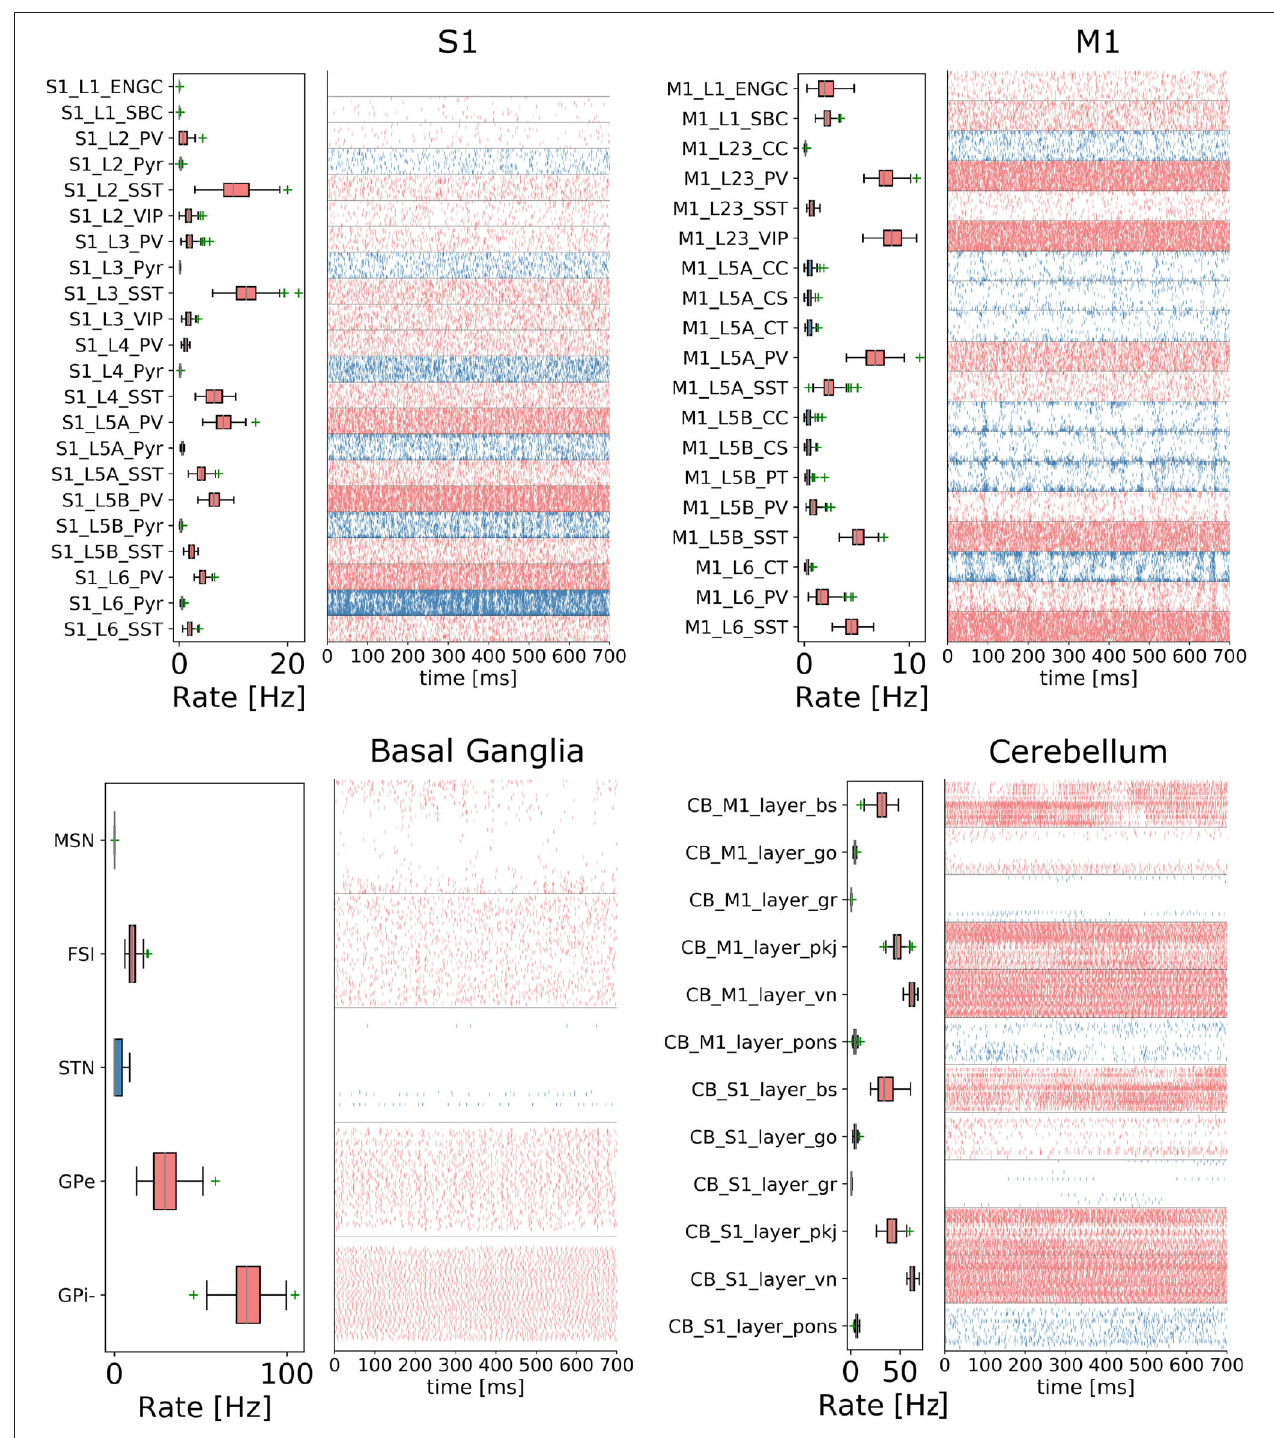
FIGURE 5 | Resting-state of the CBCT circuit (Gutierrez et al., 2020). Spike rasters (right) and mean firing rate (left) per neuron type (thalamus activity is not displayed).